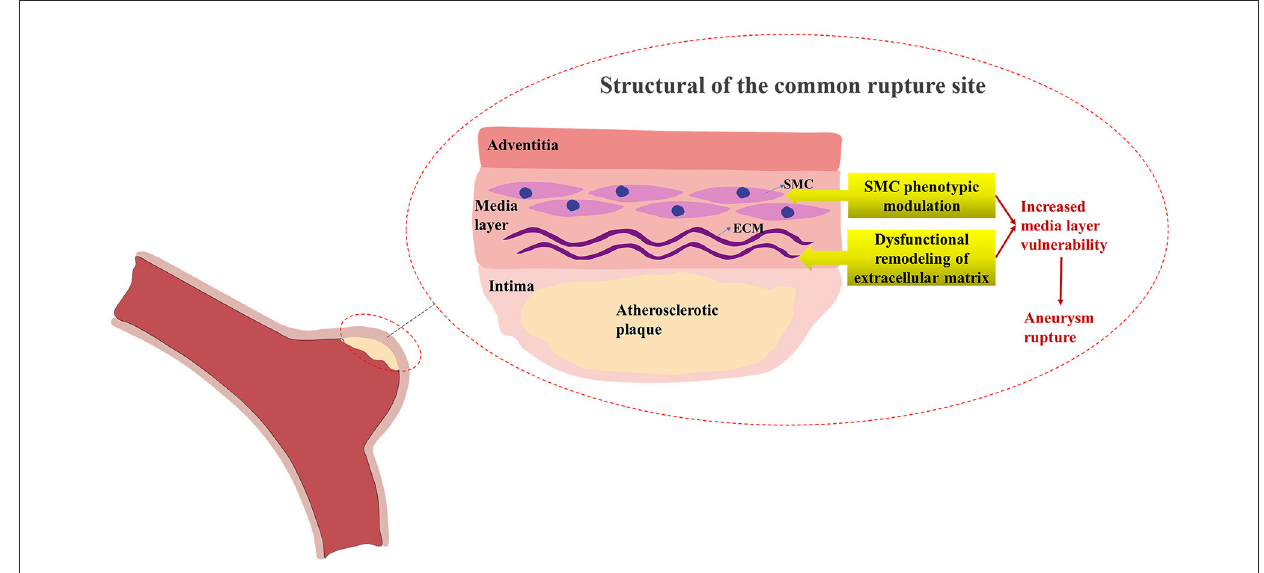
FIGURE1 Structural alterations of common rupture sites in AS-related IA.